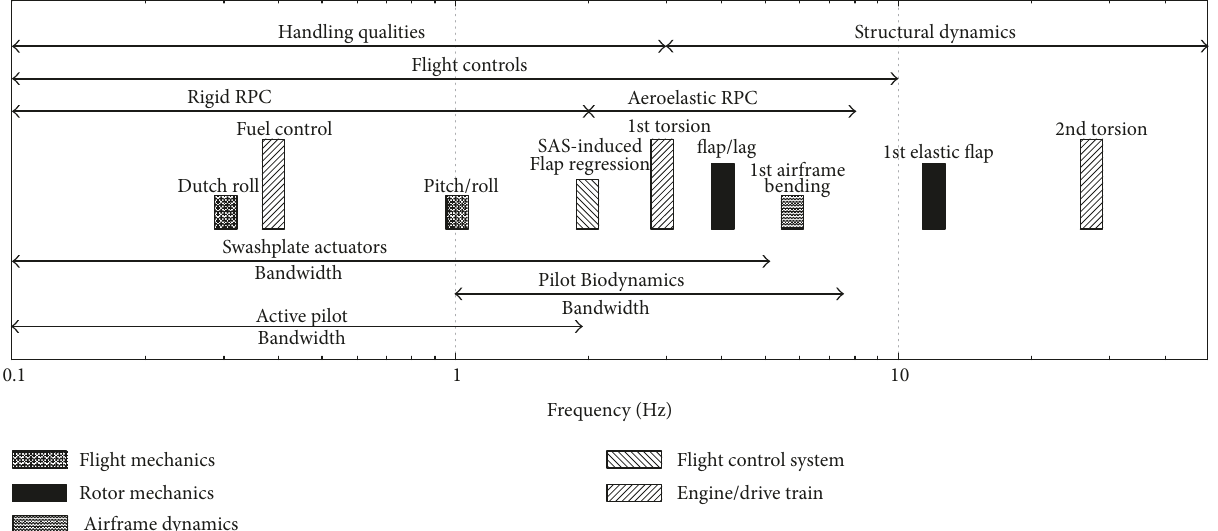
Figure 1: Typical rotorcraft frequencies (adapted from